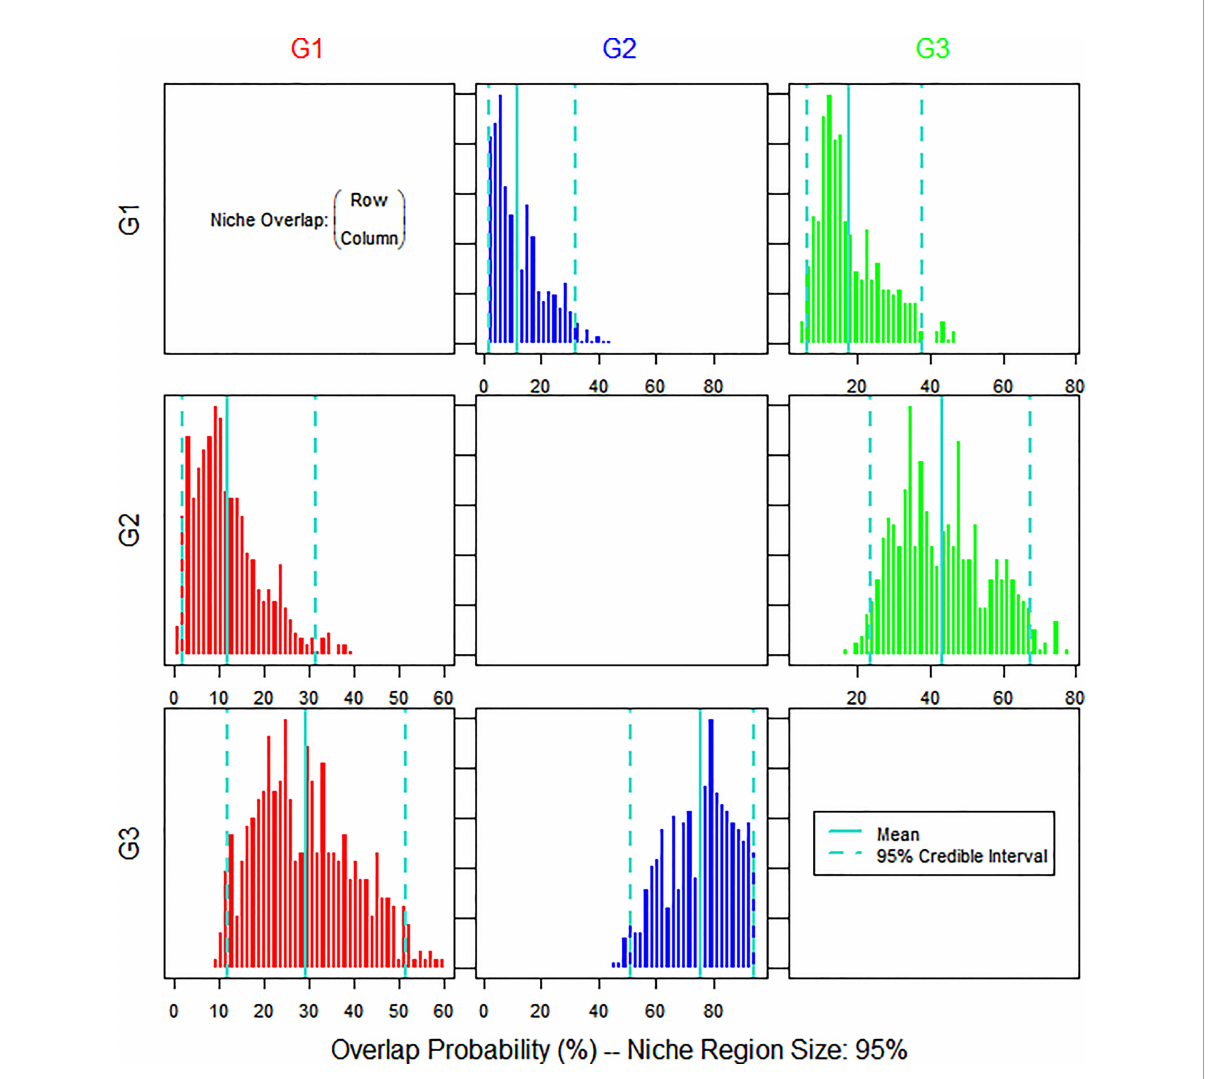
FIGURE 8 Bayesian plot of the posterior probability distribution of niche region metric (%) for the tuna species estimated using nicheROVER analysis. The posterior means and 95% credible intervals are displayed in turquoise. G1, big eye tuna, Thunnus obesus ; G2, yellow fi n tuna, T. albacares ; G3, albacore tuna, T. alalunga